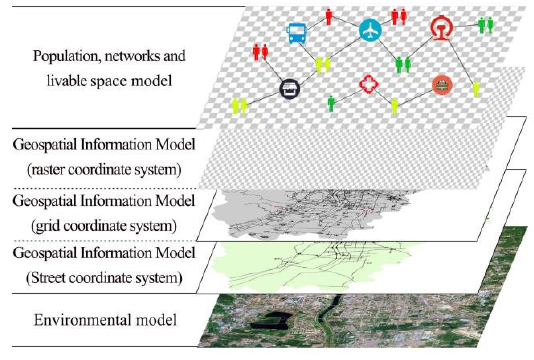
Figure 1. Model hierarchy.